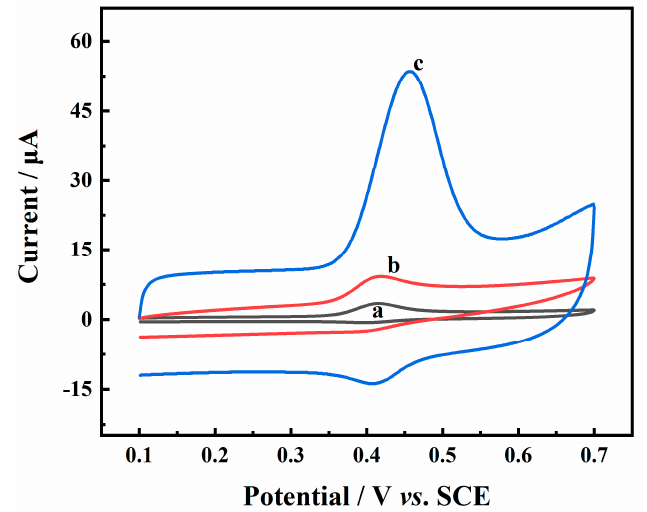
Figure 5. CVs of bare GCE ( a ), TiO 2 -MXene/GCE ( b ), and TiO 2 -MXene/PEDOT:PSS/GCE ( c ) in PB (0.1 M, pH 2.0) after accumulation in 10.0 µM baicalein for 180 s.